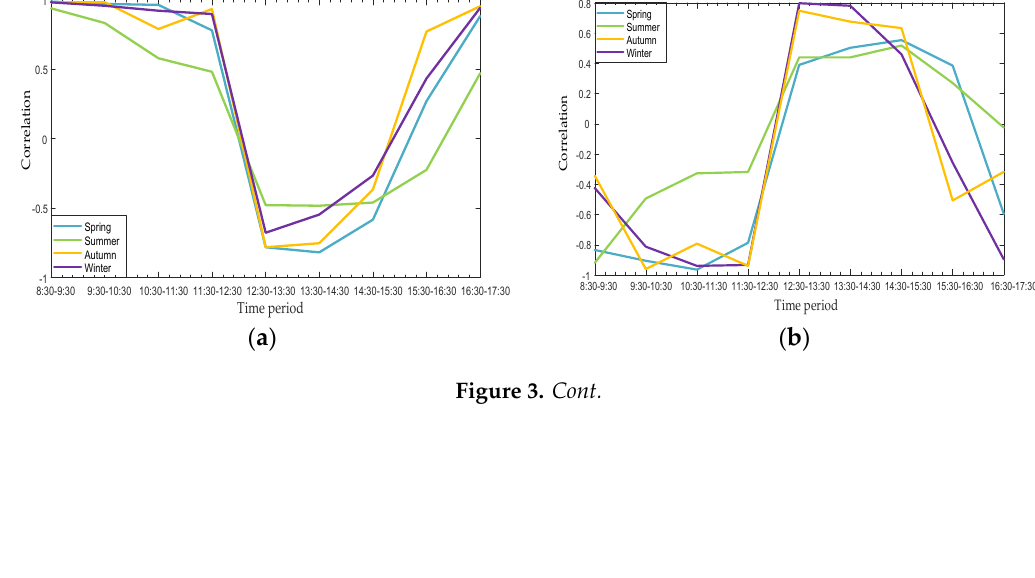
8:30–17:30, 109-time points in total, four representative and easily available meteorological factors are selected for comparison. The correlations between different features with power output at different time period are calculated by ρ d,p , and the average of three days was randomly selected.